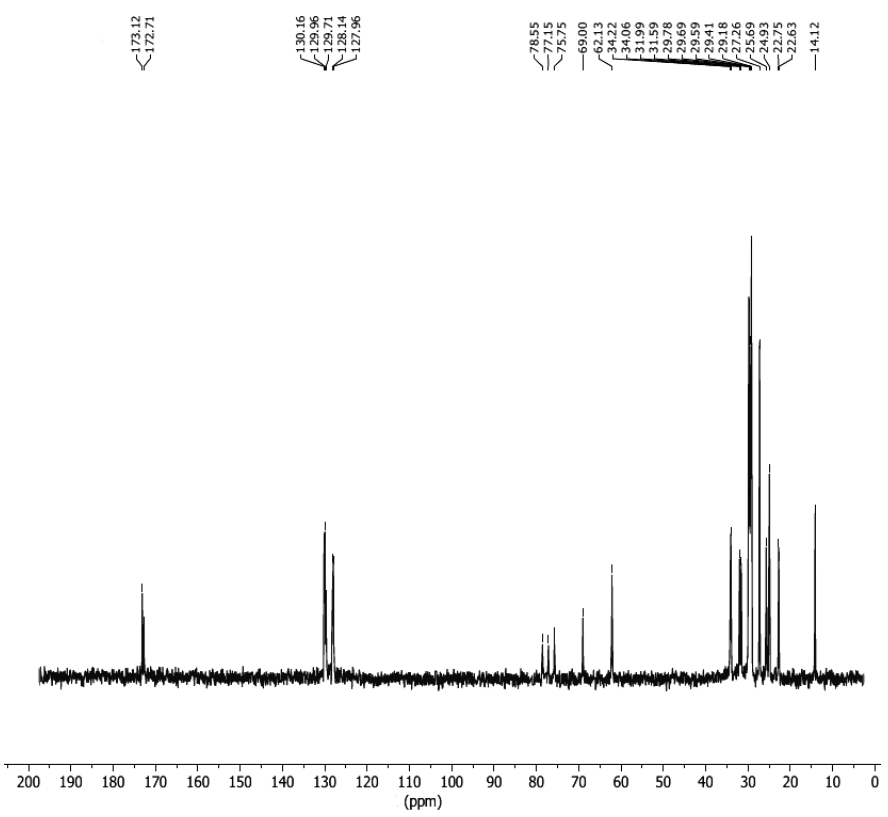
Figure 8. 13 C-NMR spectroscopy confirmation of transesterification process.